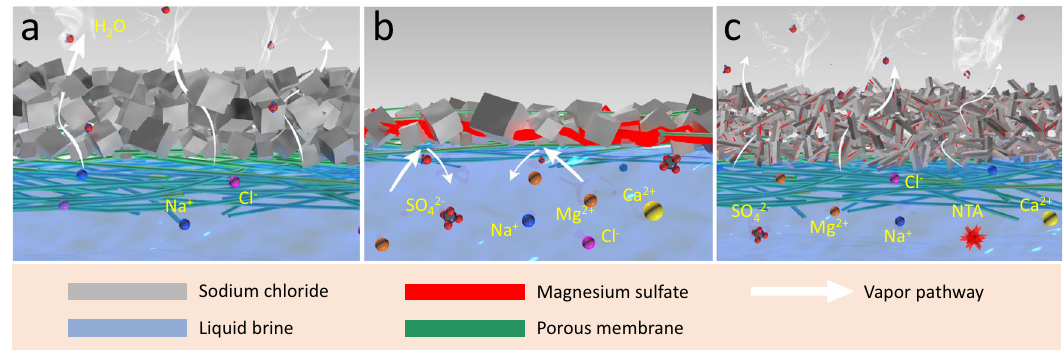
Fig. 5 Schematic illustration of accumulated salt crystals. The salt layer when using solar crystallizer to treat a pure NaCl brine, b concentrated SWRO brine and c concentrated SWRO brine with